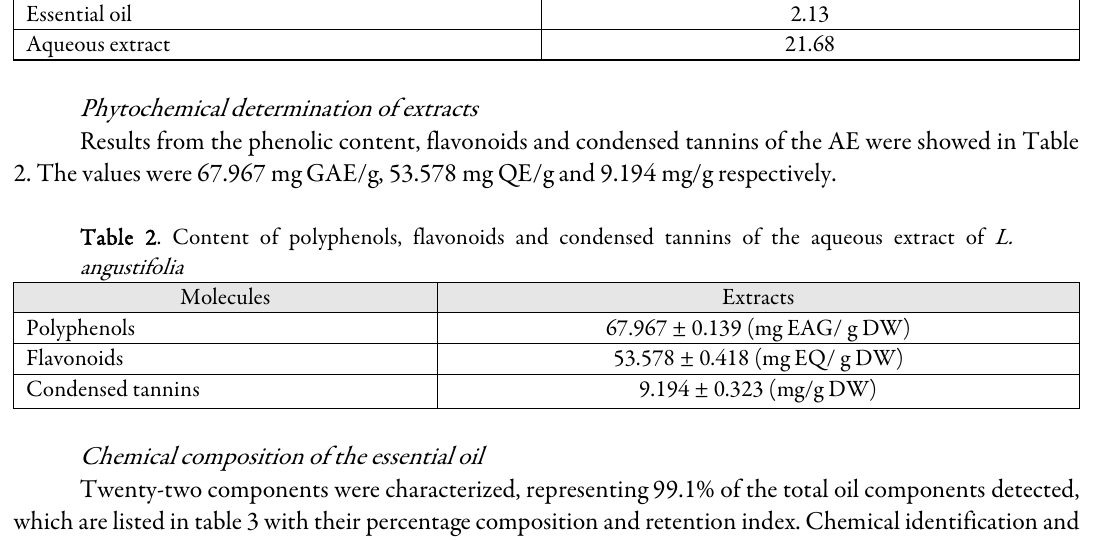
Extracts Yields (%)